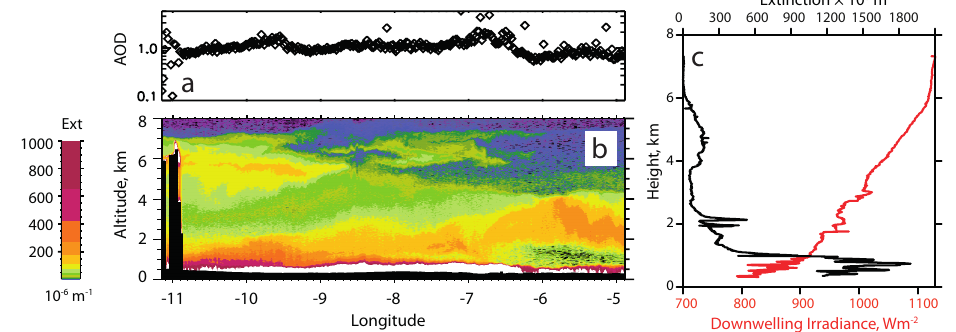
Figure 15. (a) AOD computed from the Falcon 20 LNG lidar extinction coefficient profile at around 10:00UTC on 21 June 2011, flight F22. (b) Cross section of the LNG lidar extinction coefficient (10 − 6 m − 1 ). (c) Shortwave downwelling irradiance (Wm − 1 , red) and extinction coefficient (10 − 6 m − 1 , black) as a function of the pressure during the ascent of the BAe146 from within the haboob to upper levels, flight b605. Note that the minimum pressure height of 360m is equivalent to 105m above ground